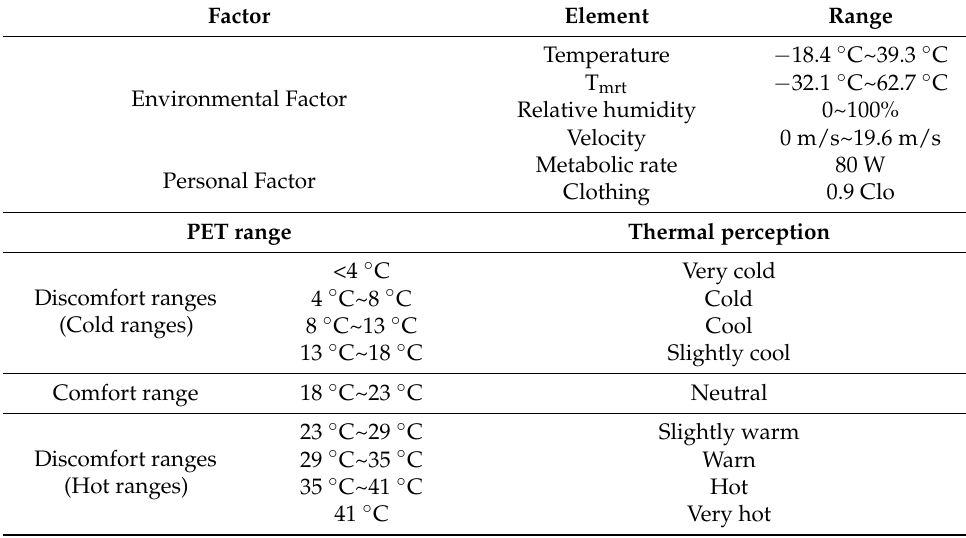
Table 3. PET variables and comfort